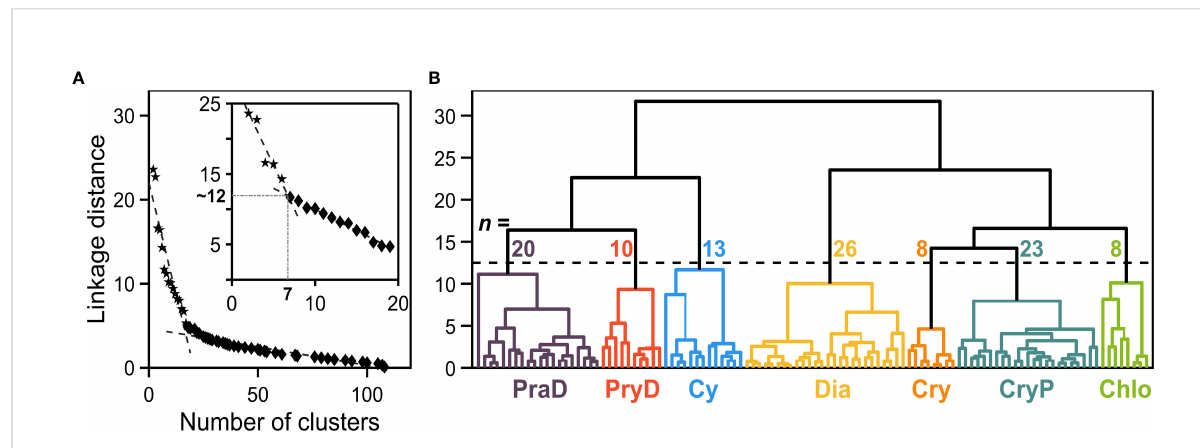
FIGURE 2 (A) Linkage distance as a function of the number of clusters obtained from the dendrogram (shown in (B) ). The L-method (Salvador and Chan, 2004) is fi rst applied considering all dataset ( n =108), and then to a restricted range for the number of clusters (inset). The resulting “ knee ” corresponds to a linkage distance cutoff of 11.9, which divides the input dataset in seven clusters. (B) Dendrogram obtained from the Hierarchical Cluster Analysis. The dashed line corresponds to the linkage distance cutoff, and the number above each cluster shows the corresponding number of samples. The clusters are denoted by PraD (purple), PryD (red), Cy (blue), Dia (yellow), Cry (orange), CryP (teal) and Chlo